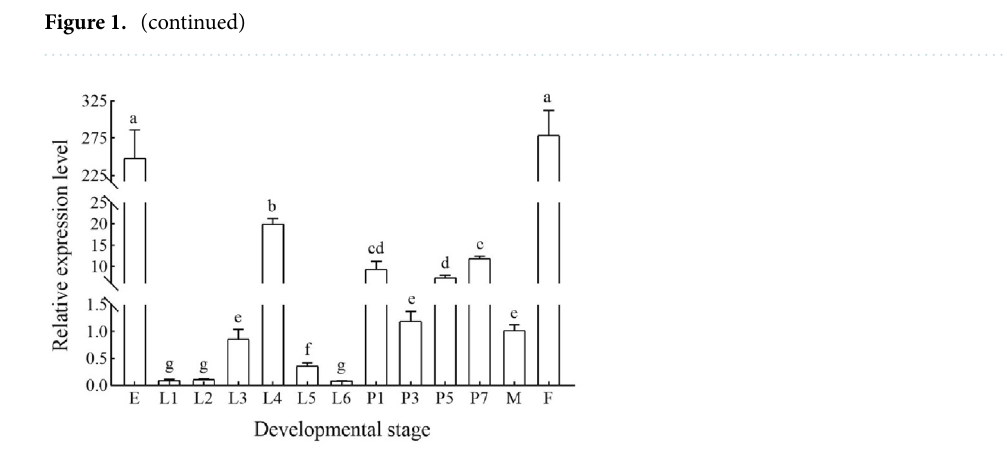
Figure 2. Relative expression levels of Hap38 MAPK in different developmental stages of H. armigera . E (Egg), L1–L6 (1st–6th instar larva), P1, P3, P5, P7 (1-, 3-, 5-, and 7-day-old pupa), F (3-day-old adult females) and M (3-day-old adult males). The expression levels of the genes in the adult males are normalized. Data in the figure are expressed as mean ± SE. Different letters above bars indicates significant difference. The values with same superscript letters in the same line are of no significant difference ( P > 0.05), those with different letters are of significant or extreme difference ( P < 0.05,